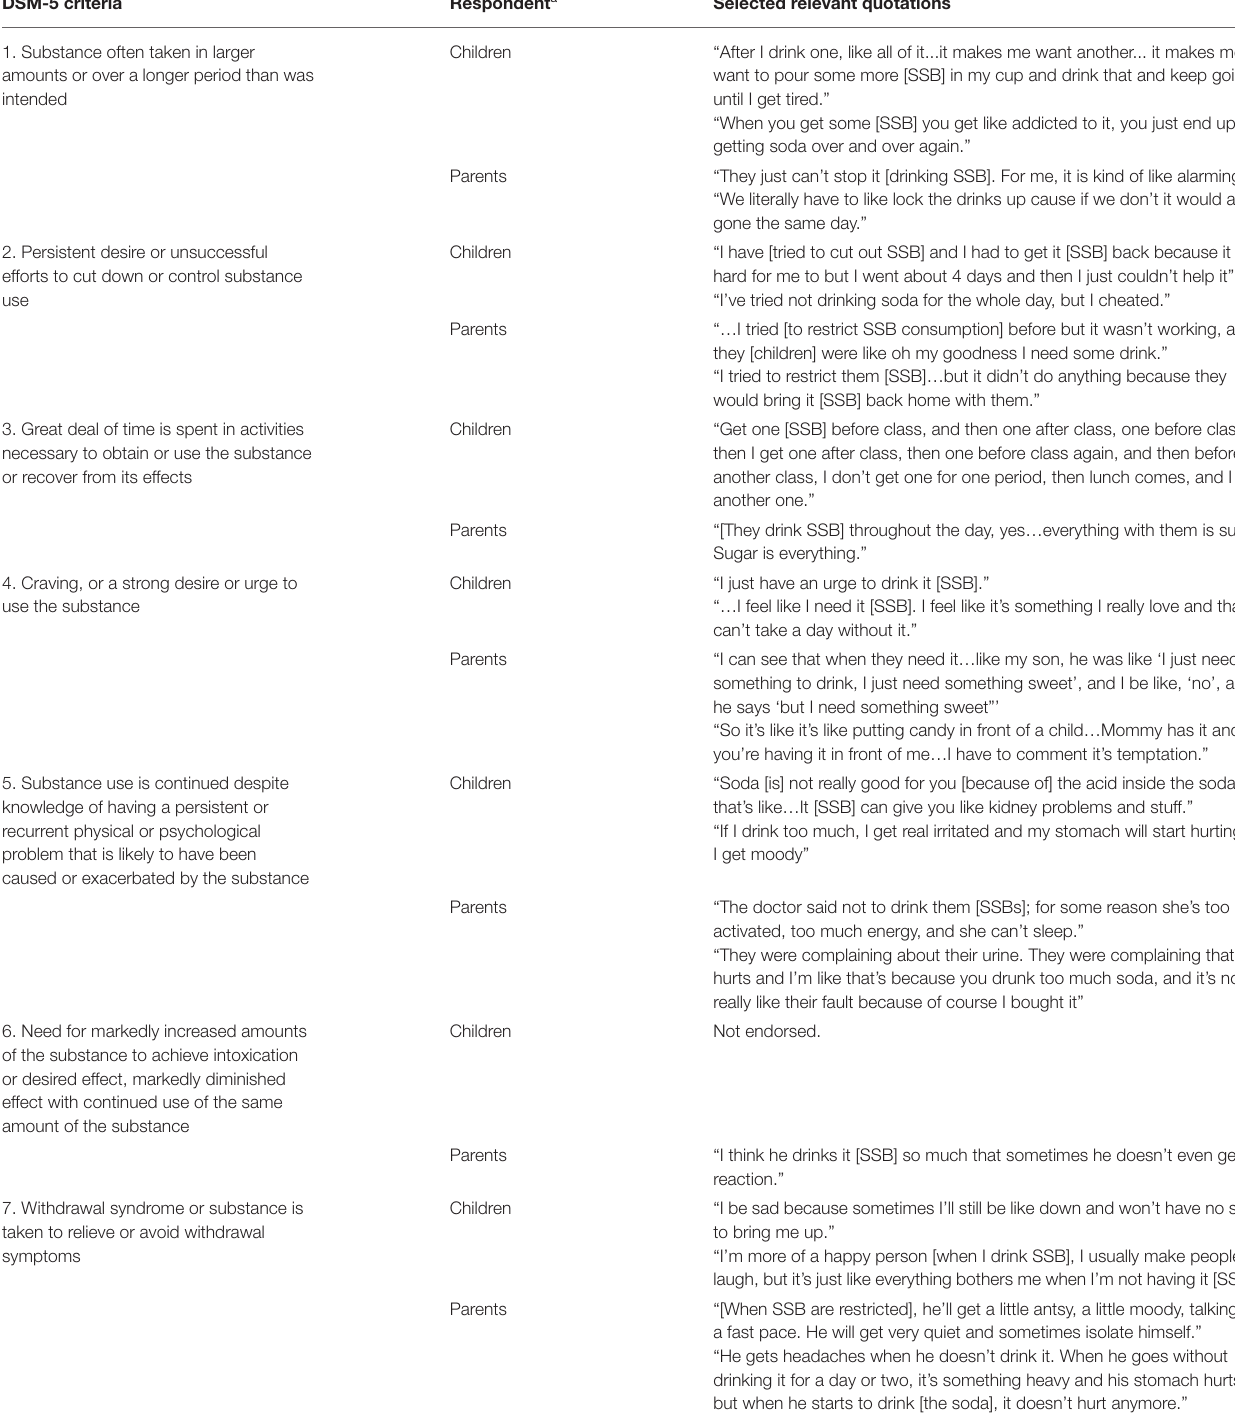
TABLE 1 | Parent and/or child-reported sugar-sweetened beverage consumption behaviors consistent with DSM-5 substance use disorder (SUD) criteria. DSM-5